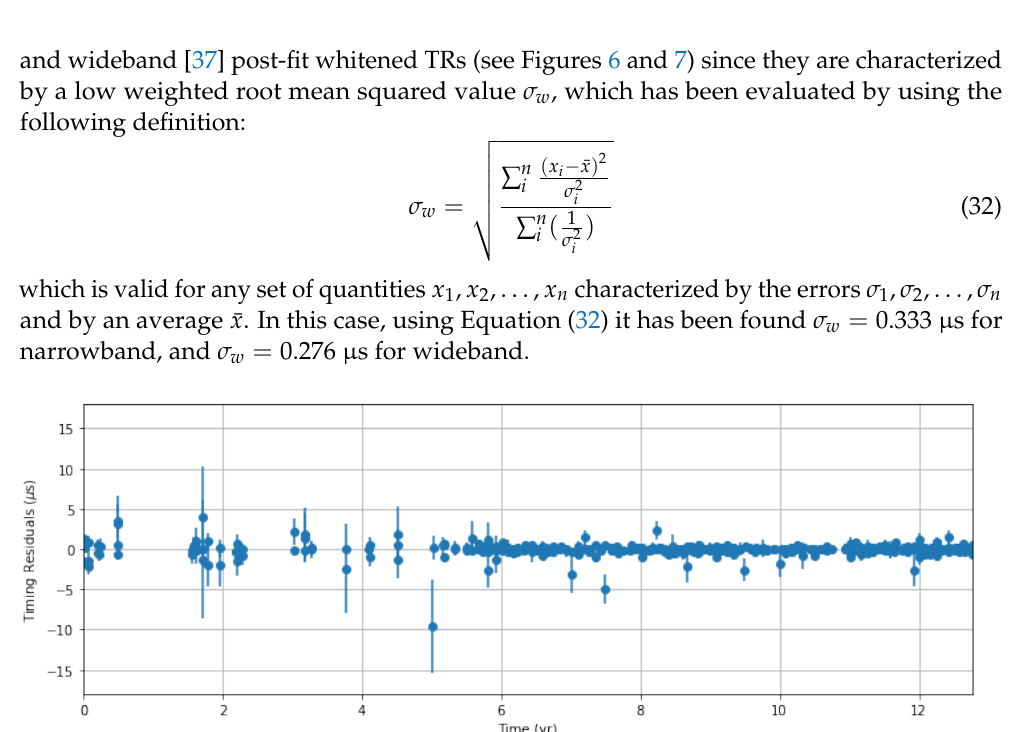
Figure 6. Plot of the averaged narrowband post-fit whitened TRs of the MSP J2145–0750, which are from the 12.5 yr Data Set published by the NANOGrav collaboration. The horizontal axis indicates the time, expressed in years. The vertical axis indicates the averaged narrowband post-fit whitened TRs, expressed in nanoseconds.